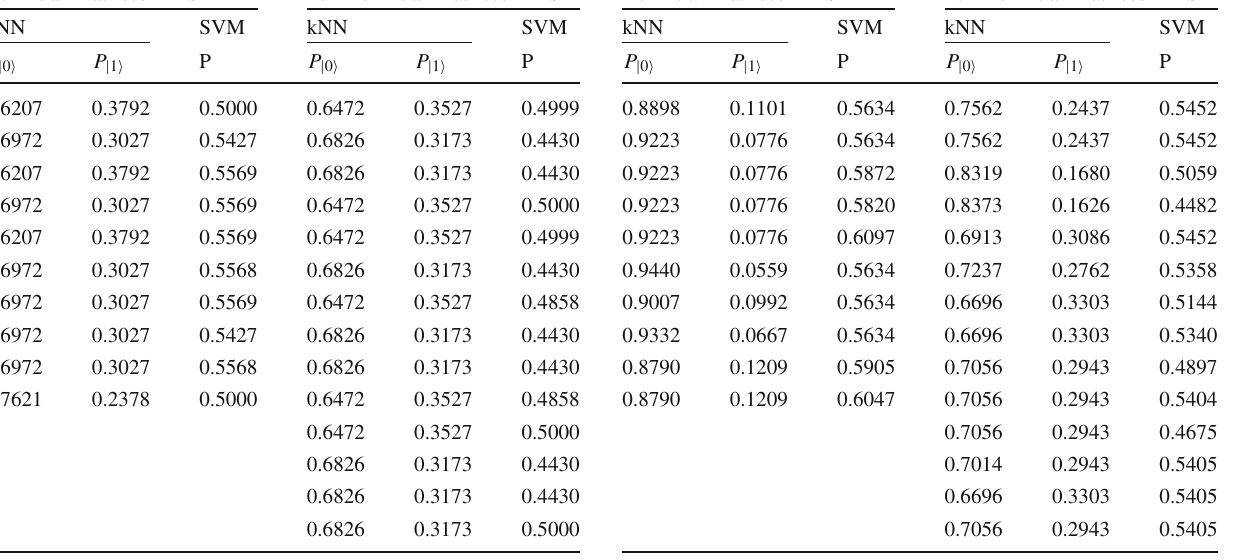
Table 2 Results of pattern recognition for quantum versions of kNN and SVM methods Hermitian matrices in TS non-Hermitian matrices in TS